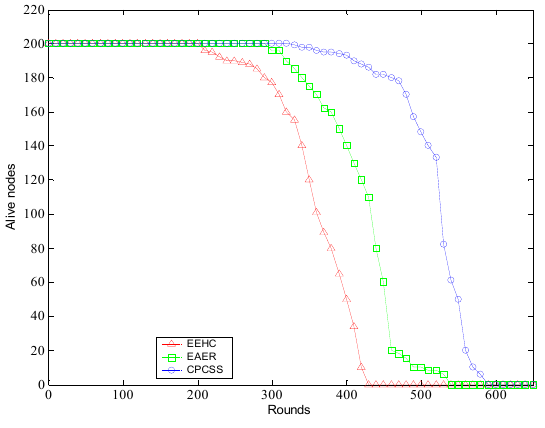
Figure 15. The alive nodes over rounds.